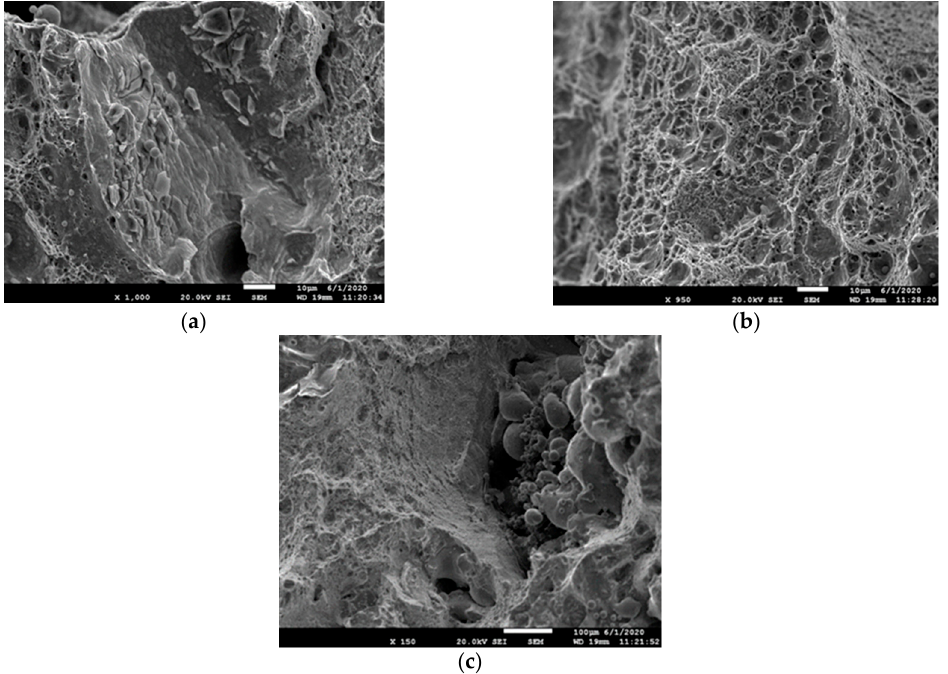
Figure 7. The fractured surface of the chessboard family 1 (samples 10–12) with ( a ) oxide impurities, ( b ) ductile dimples, and ( c ) unmelted particles, suggesting a lack of fusion.